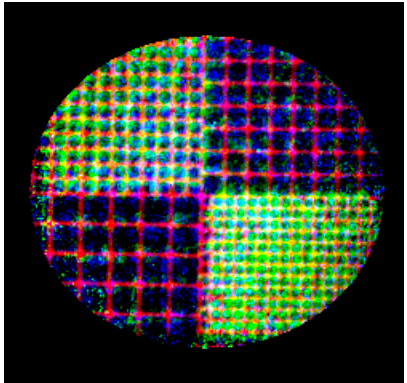
𝑇𝑛𝑜𝑟𝑚 𝑇𝑛𝑜𝑟𝑚 , the green , the green , the green T